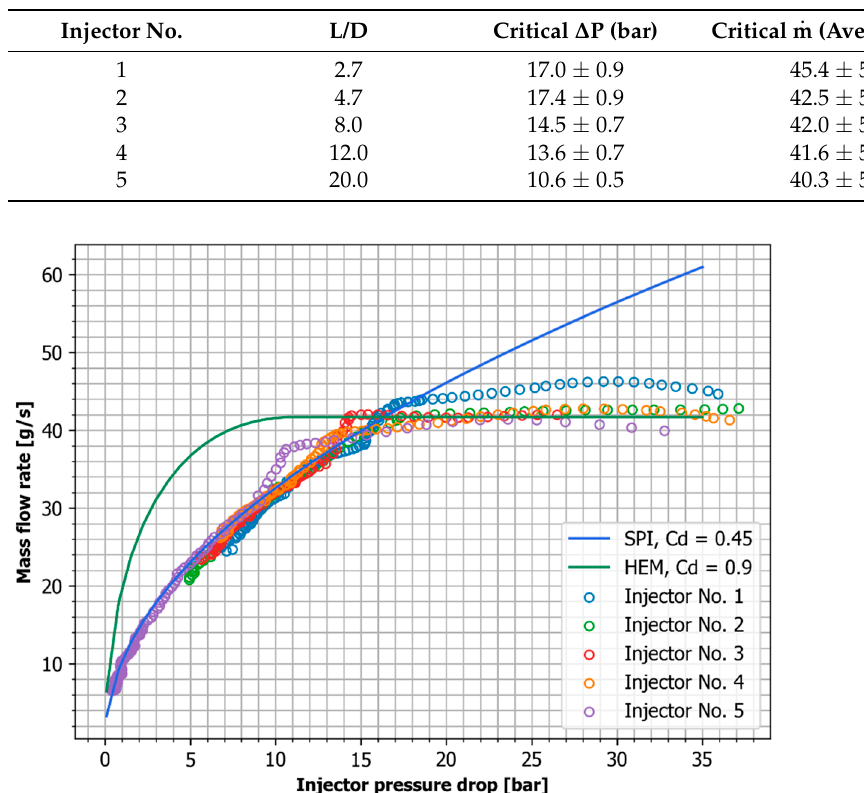
Table 2. Critical flow data for all injectors.